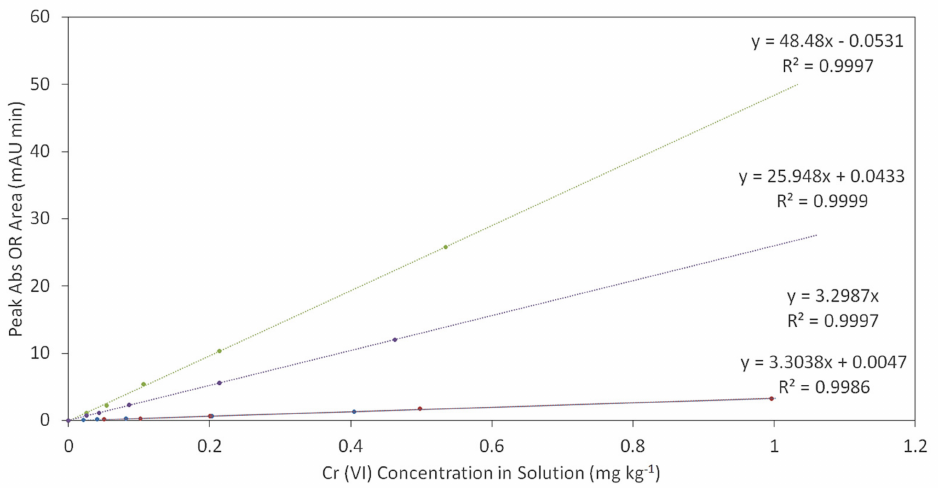
Figure 7. Absorbance vs. concentration calibrations for all BS EN ISO 17075 methods: colorimetric at 40 mm path length (Blue), direct chromatographic at 50 uL injection (red), Cr (III)-Carbazone chromatographic 50 µ L injection (purple) and 100 µ L injection